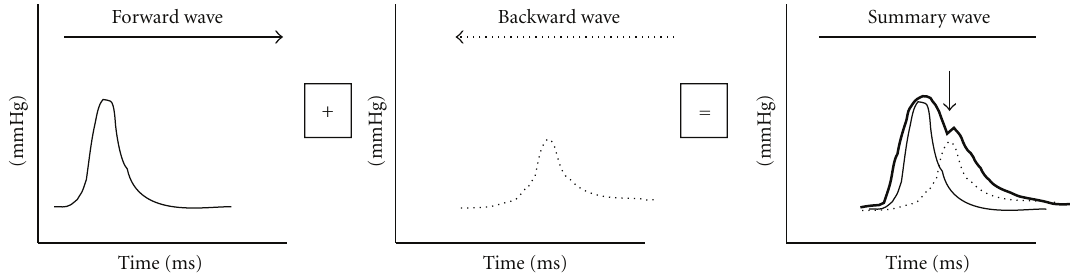
Figure 2: Pictorial representation of summation (right) e ff ects on the arterial pressure waveform resulting from forward (left) and backward (i.e., “reflected”; middle) wave integration.